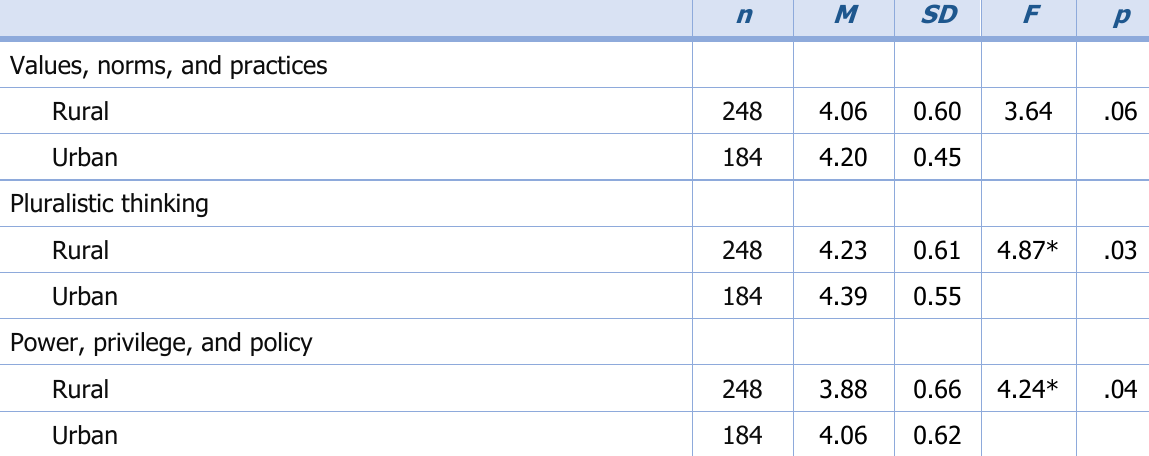
Table 6. Differences Between 4- H Extension Agents’ Perceived Importance of t he AEO Domain’s Awareness Components and the Rural/Urban